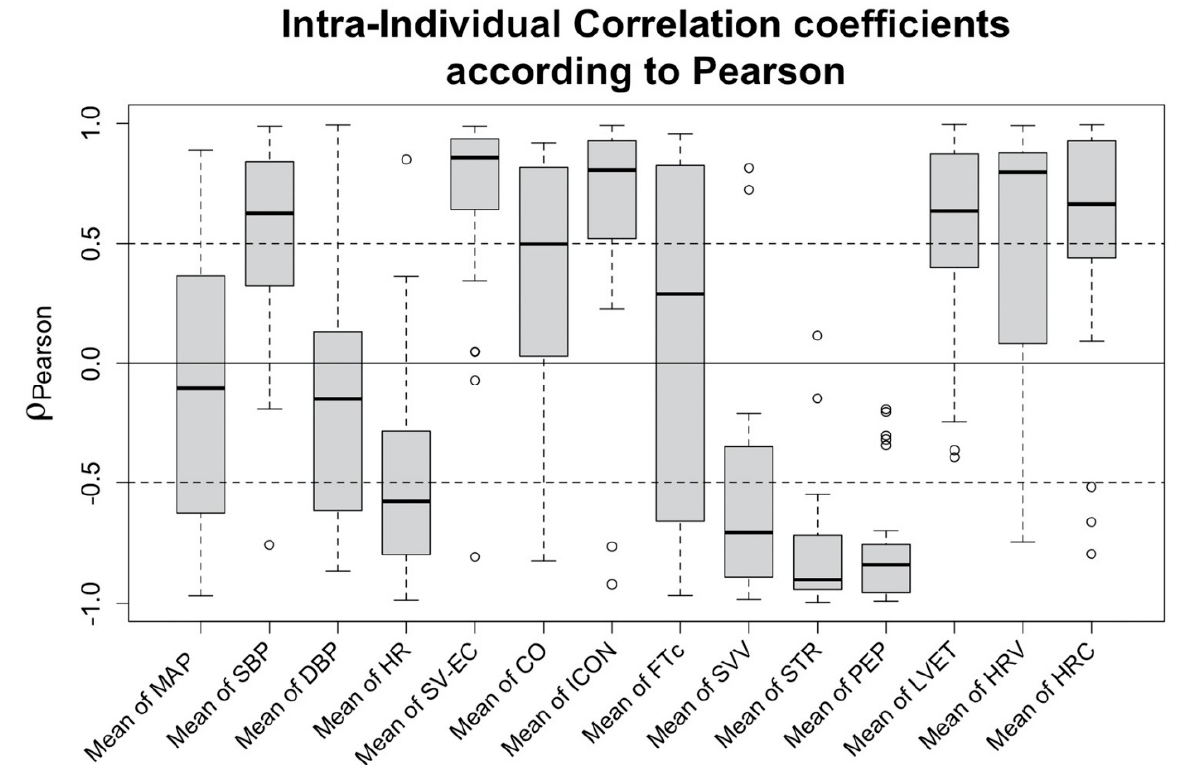
Figure 4. Boxplots of the correlation between the selected features and TTE-SV: Intra-individual correlation (according to Pearson) between haemodynamic values and SV-TTE. Each boxplot represents 29 correlation coefficients, one for each test subject. Black rings represent outliers.